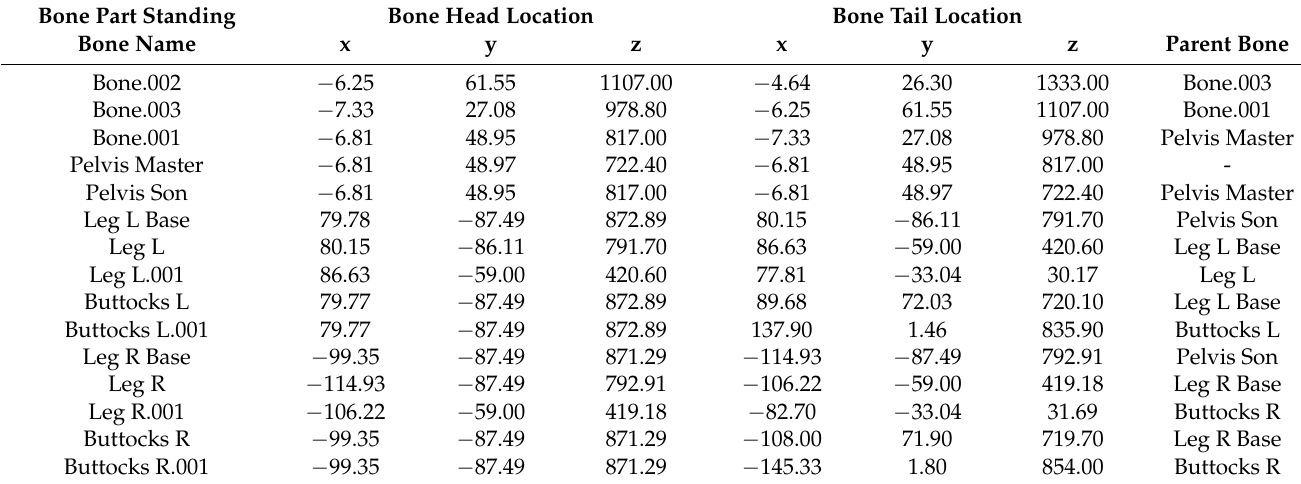
Table 2. Armature’s absolute x, y and z coordinates for every bone’s head and tail in Blender 3D, for the standing posture of a scanned person.